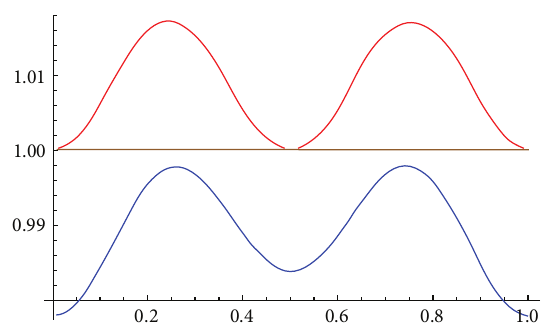
Figure 6: |𝑆 12 (𝛼)| = 1,|𝑆 34 (𝛼)| = 1 .